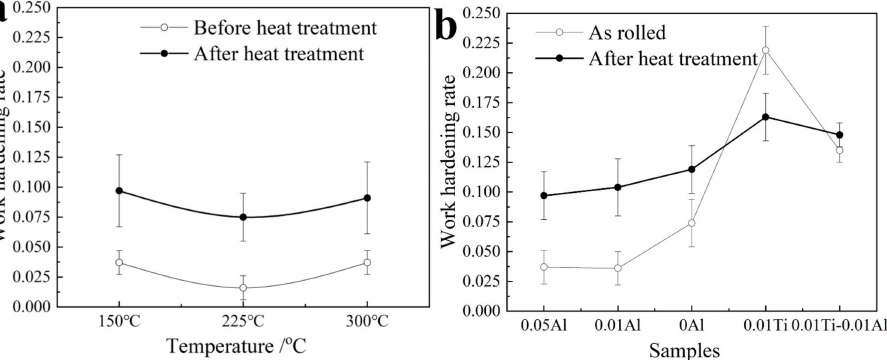
Figure 11. Simulation of true strain and strain to determine the work-hardening rate, ( a ) the samples for different heat treatments of Ti, and ( b ) the sample for different Al layer